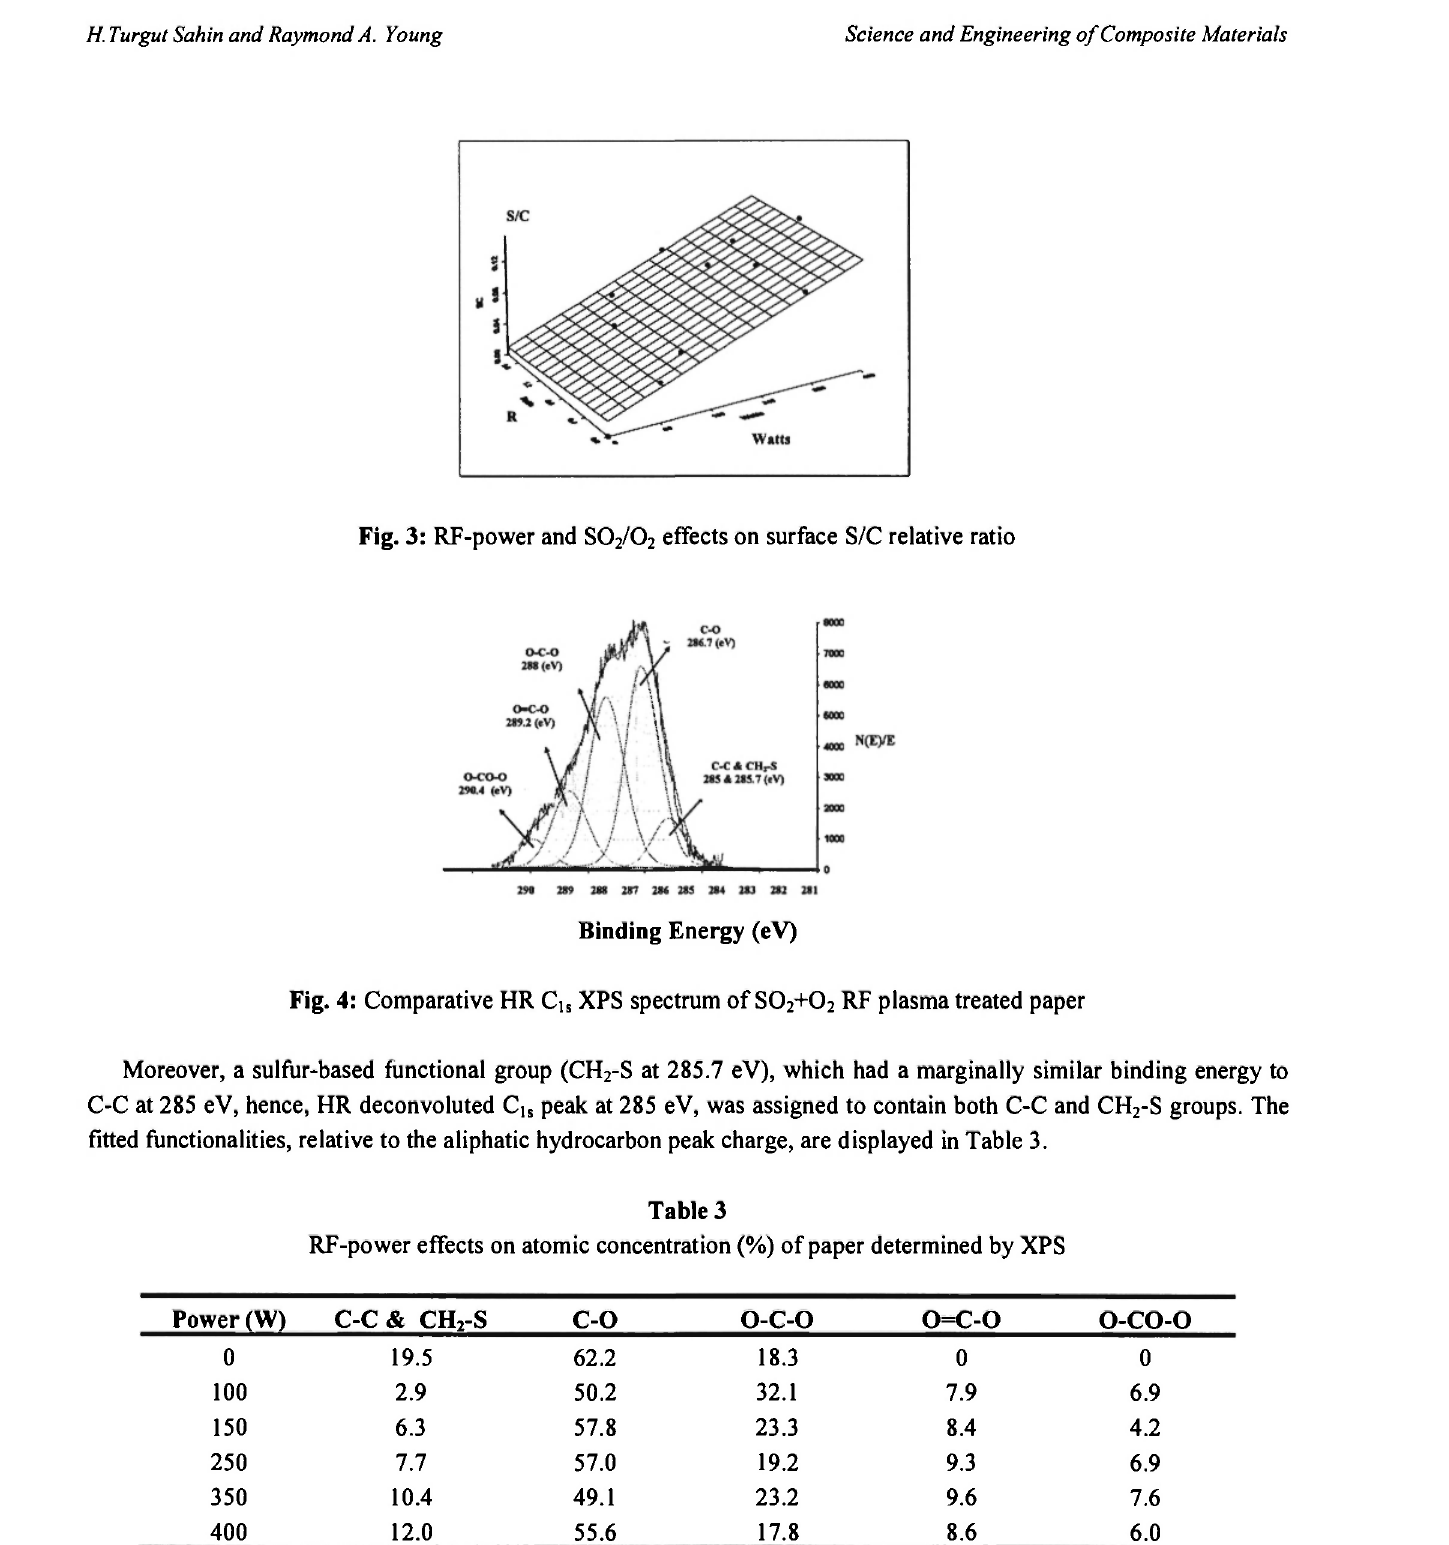
RF-power effects on atomic concentration (%) of paper determined by